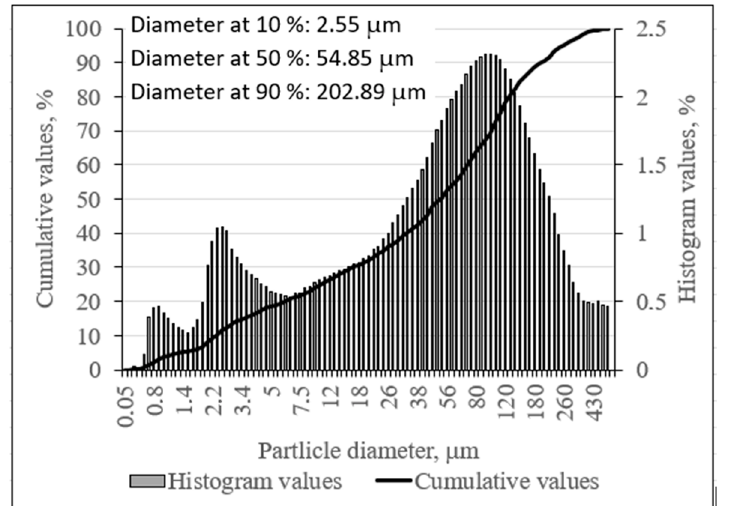
Figure 2. The mineral composition (X-ray diffraction patterns) and microstructure of slag. Notes: CC—calcium carbonate, CaCO 3 (72–1651); Q—quartz, SiO 2 (83–539); H—hydrotalcite, Mg 6 Al 2 CO 3 (OH) 16 ·4H 2 O (14–191).